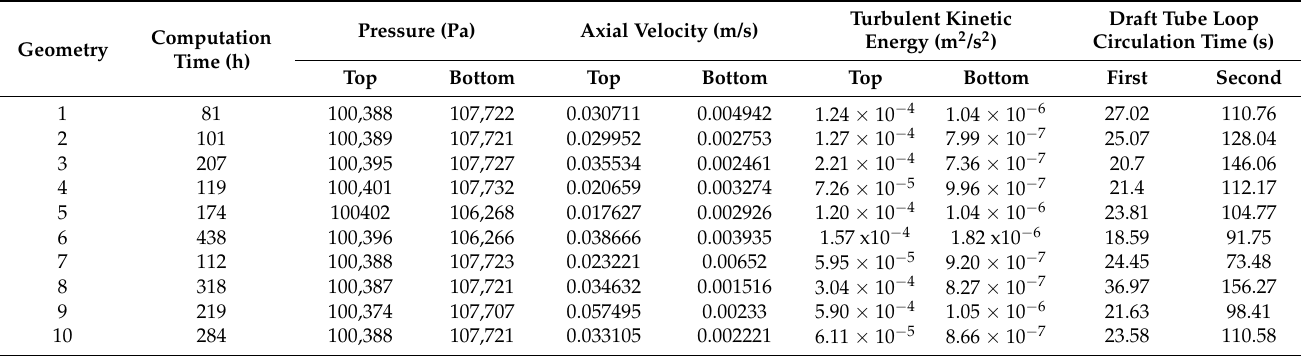
Table 4. Results from the